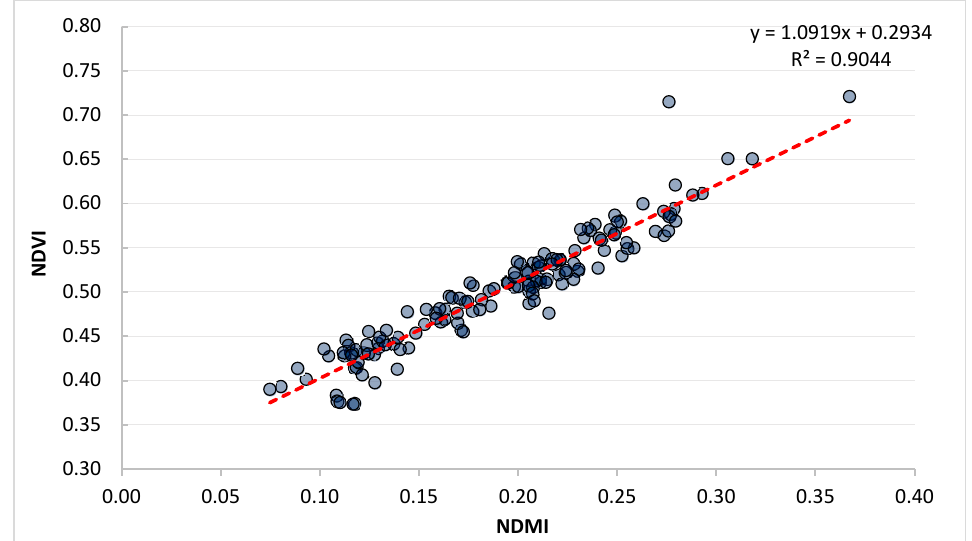
Figure 11. NDMI Correlation with NDVI-wheat in 143 Center pivot wheat Field -2021.